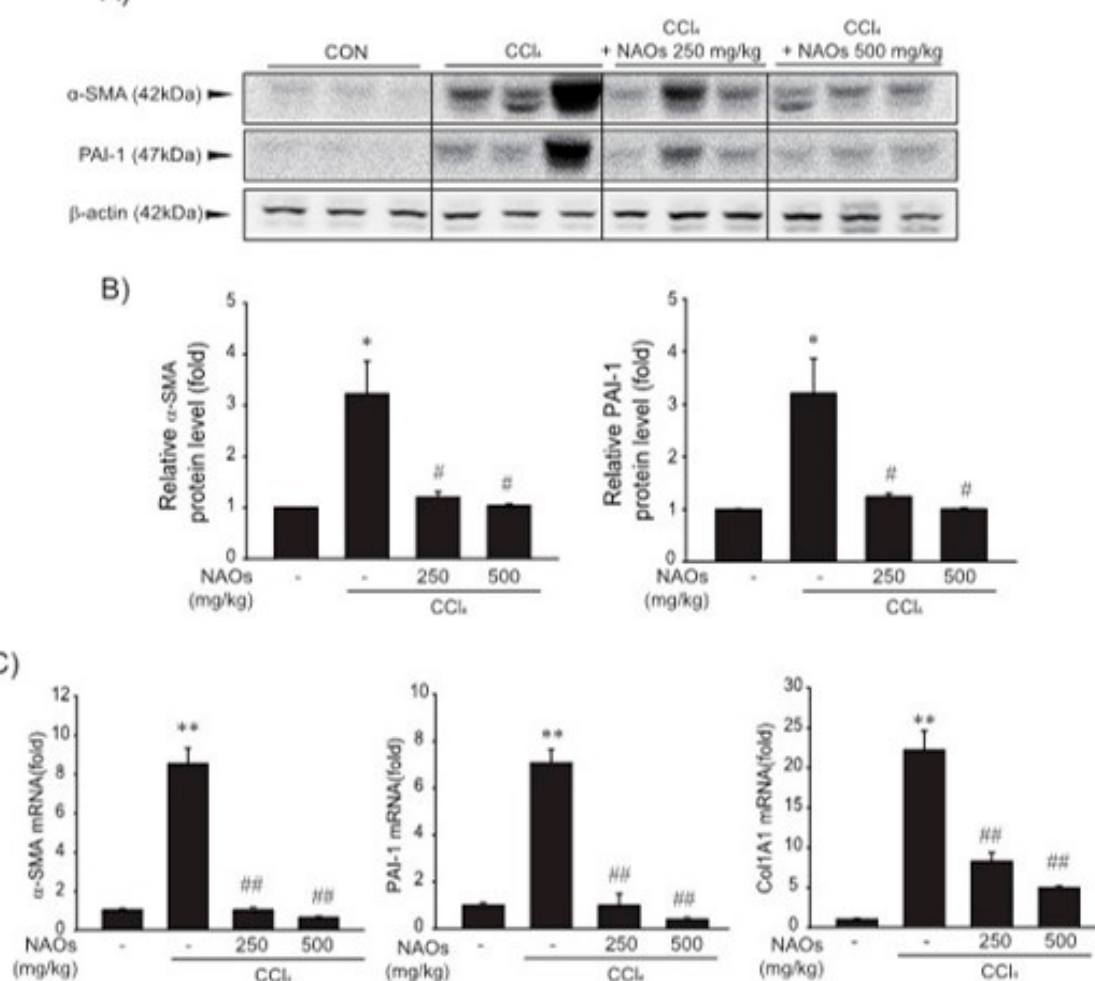
Figure 5. Inhibition of CCl 4 -induced expression of fibrogenic genes by neoagarooligosaccharides (NAOs). ( A , B ) Western blot analysis. α -SMA and PAI-1 protein levels assessed by immunoblotting. ( n = 3). Results are presented as means ± S.E. of three replicates. ( C ) α -SMA, PAI-1, and Col 1A1 transcripts in CCl 4 -induced mice liver assessed by real-time PCR analysis ( n = 3). Results are presented as means ± S.E.; ** p < 0.01, * p < 0.05, vs. vehicle control; ## p < 0.01, # p < 0.05, vs. CCl 4 ; CON, vehicle